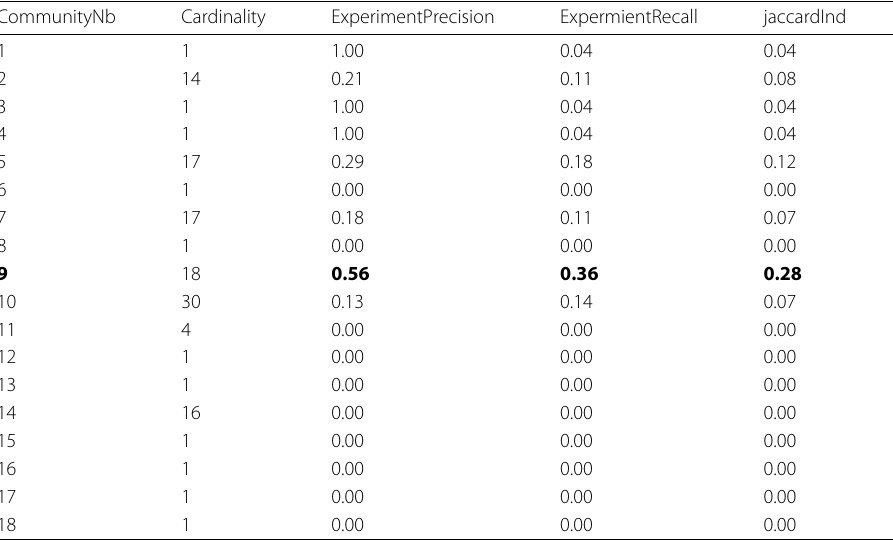
Table 15 Communities detection with the Louvain algorithm applied to the one mode projection pathways network, Modularity is